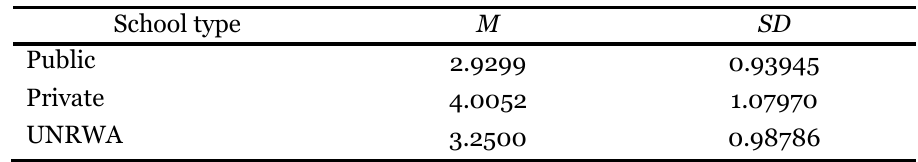
Means and Standard Deviations of Parents’ Perceptions Toward the Distance Learning Process According to School Type